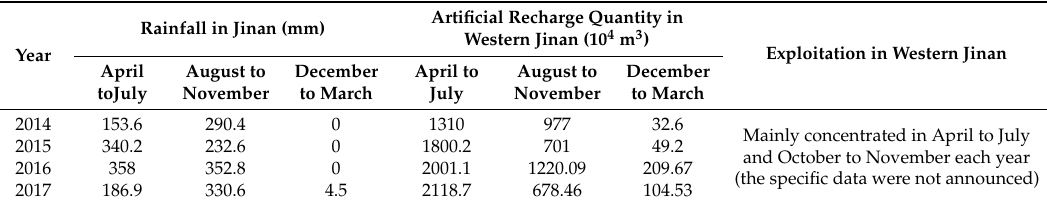
Table 5. Rainfall and artificial recharge quantity during different